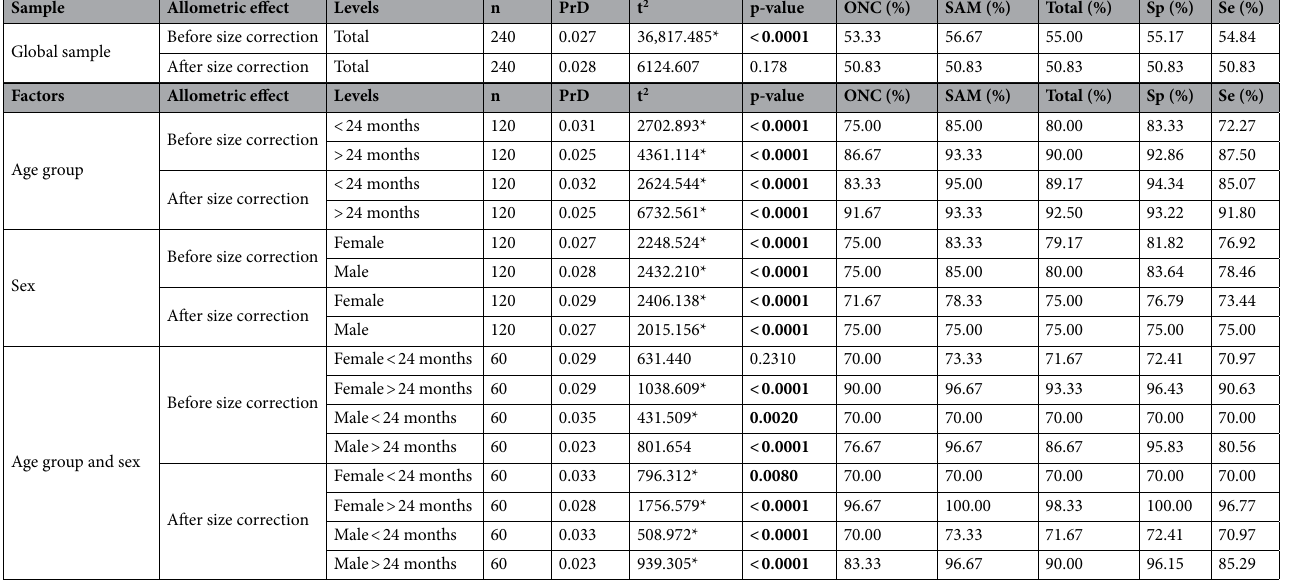
Table 2. Ontogenetic and sexual effect on nutritional status determination in the whole body. Discriminant Function Analysis (DFA) cross-validated (CV) results for nutritional status determination in the whole body of children considering age groups and sex independent and combined effect. Procrustes distance means difference (PrD), Hotelling t2 statistic (t2). (*) Significance level: p < 0.01, after 10,000 permutation runs. Optimal nutritional condition (ONC), severe acute malnutrition (SAM). Specificity (Sp) and sensibility (Se) estimated for